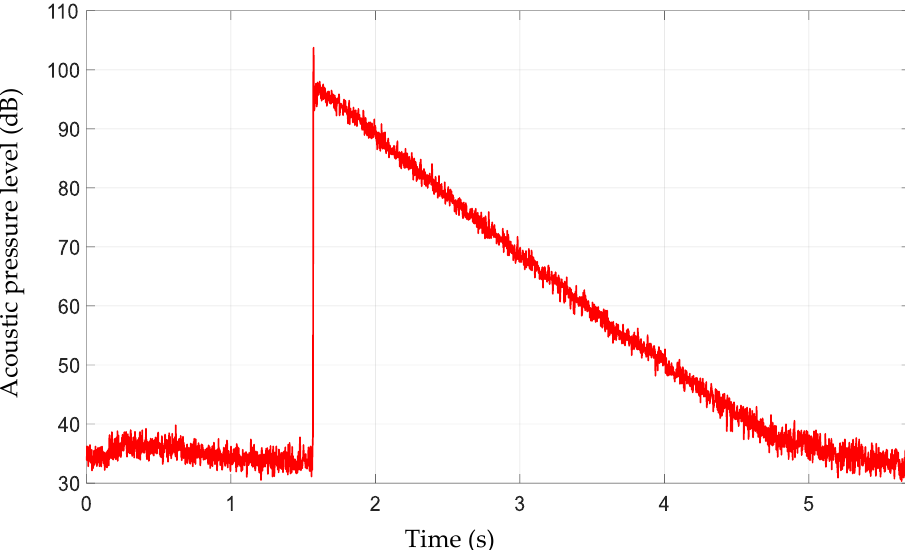
Figure 4. Averaged sound pressure level decay.